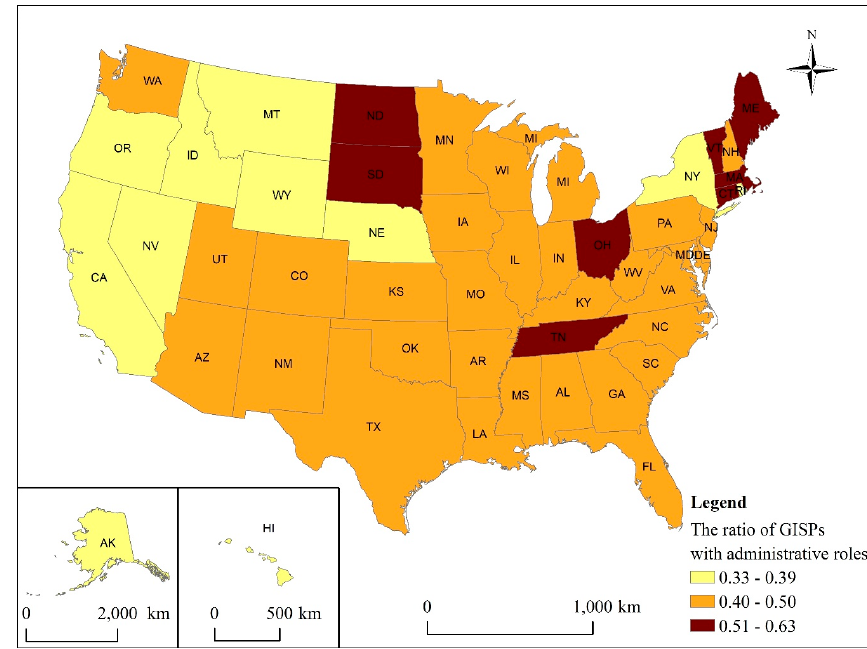
Figure 5. The map of the ratio of GISPs with an administrative role in each state.